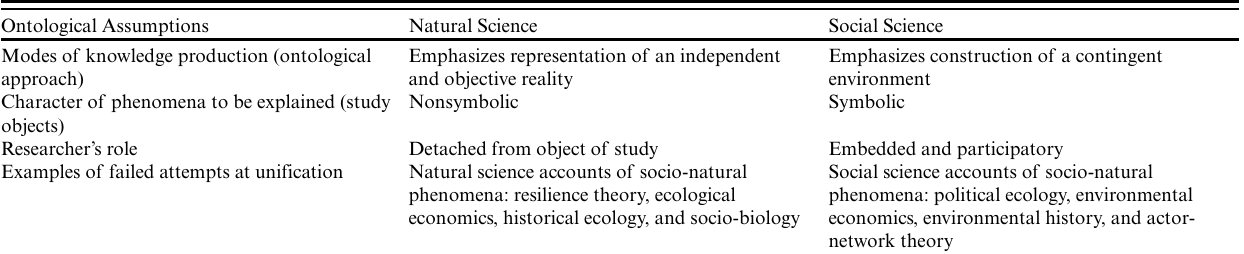
Table 1 . Frequent barriers to integration and communication between social and natural